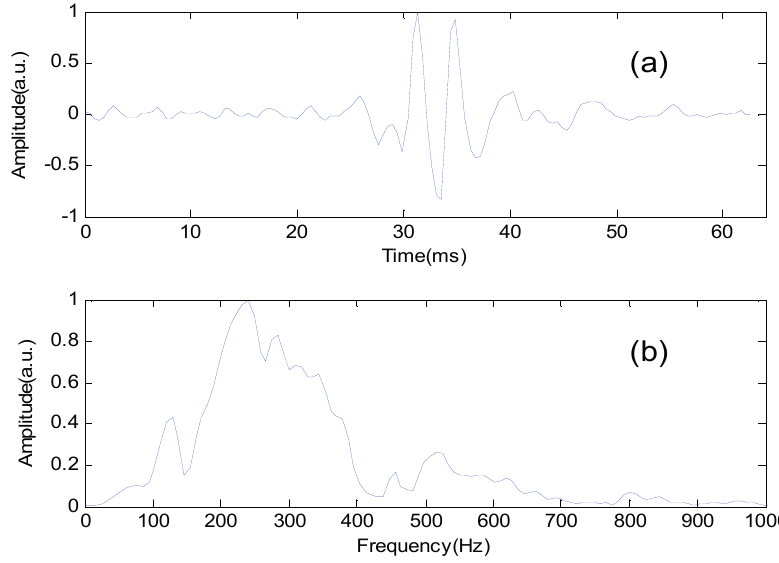
Figure 4. The second heart sound and its frequency